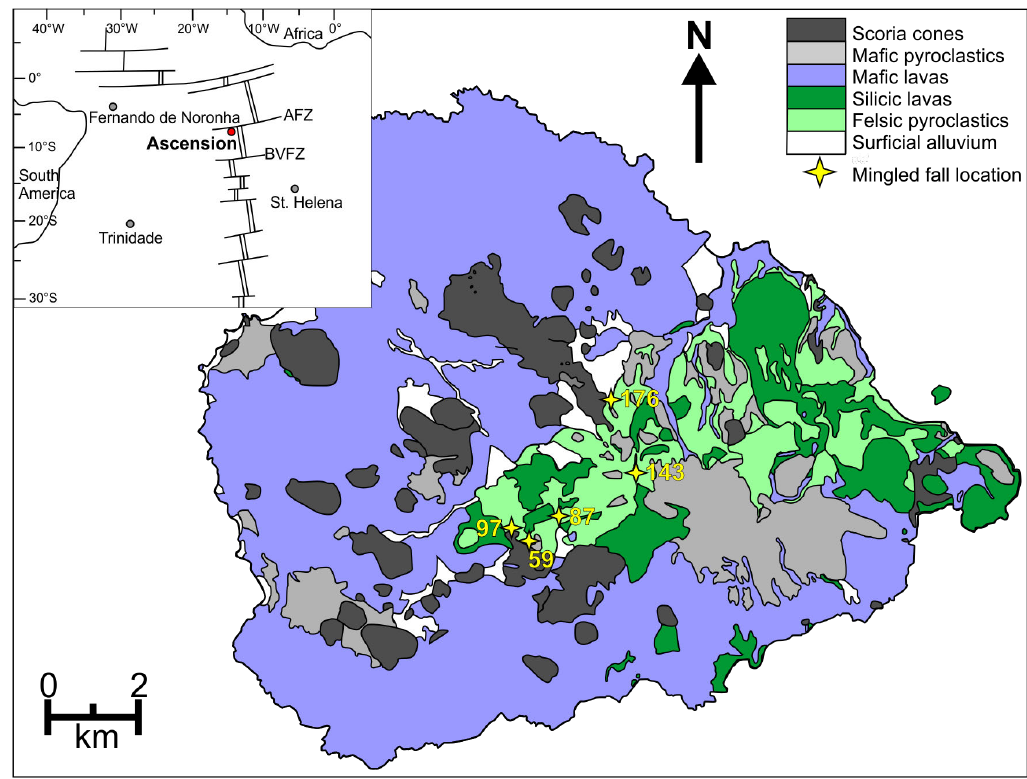
Figure 1: Geological map of Ascension Island adapted from Chamberlain et al. [2019] showing the location of the mingled fall deposit (yellow stars). Numbers in yellow relate to deposit thickness in cm . Inset shows the location of Ascension relative to the Ascension Fracture Zone (AFZ) and the Boca Verde Fracture Zone (BVFZ). ary between L2B and L3 is di ff use over ~2 cm. L3